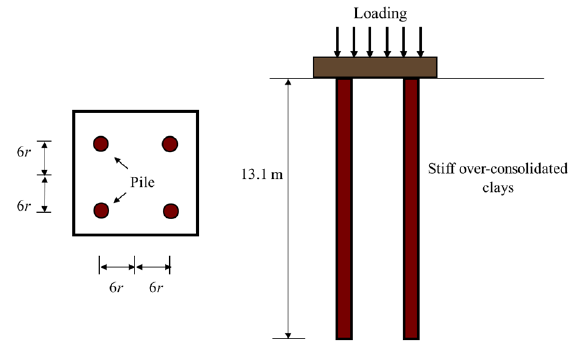
Figure 9. Layout of the group piles and subsoil